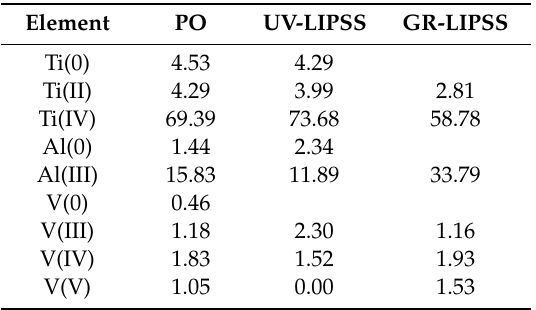
Table 4. Quantitative results for the metallic elements in atomic